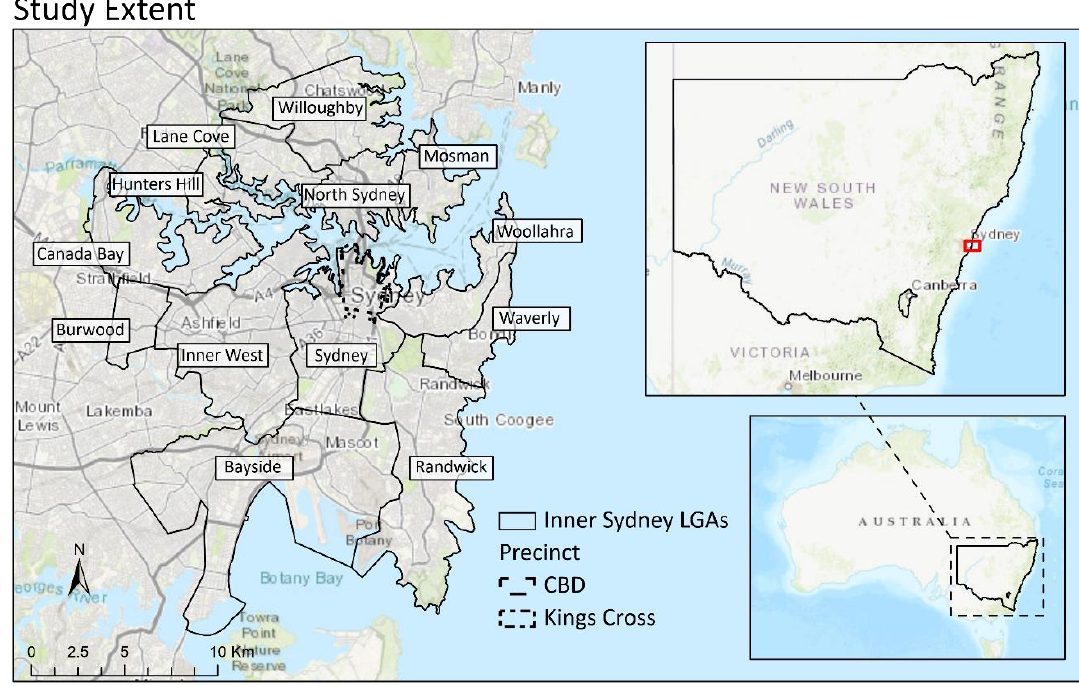
Figure 1. Study Extent.